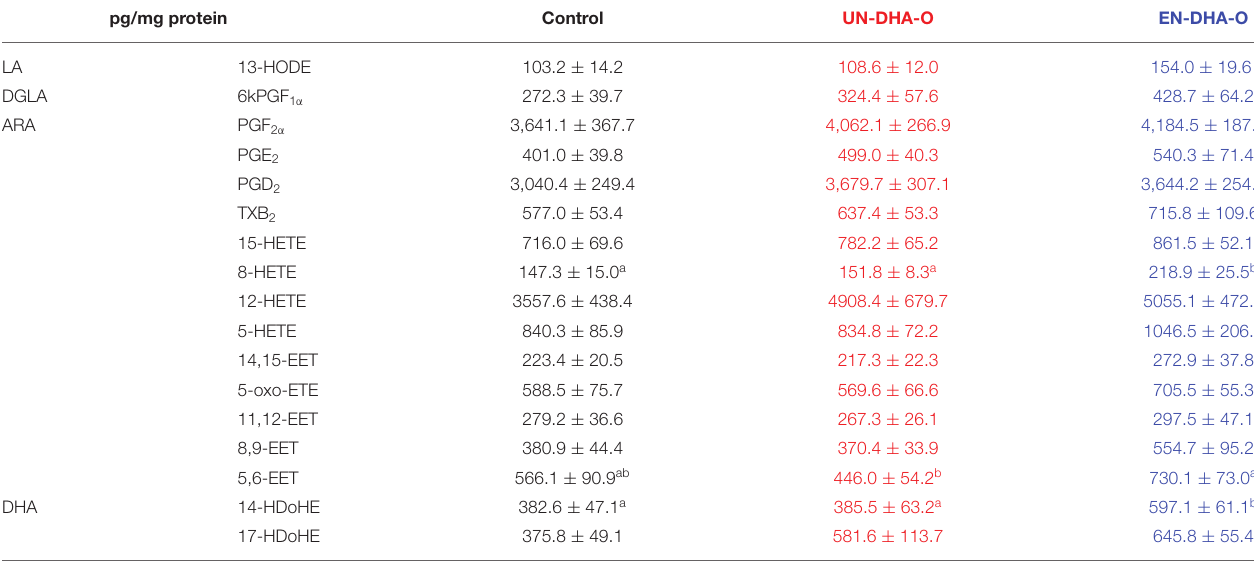
TABLE 8 | The oxidized derivatives of fatty acids from brain. pg/mg protein